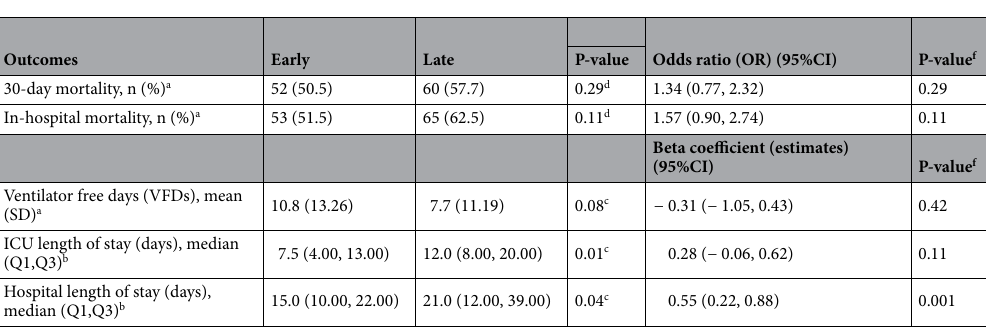
Table 2. Regression analysis of mortality, VFDs, and length of stay after propensity score. a Denominator of the percentage is the total number of patients. b Denominator is patients who survived. c Wilcoxon rank sum test is used to calculate the P-value. d Chi-square test is used to calculate the P-value. f Propensity score matched used based on patient’s SOFA score, MV within 24 h of ICU admission, proning position, and early use of Tocilizumab within 24 h of ICU